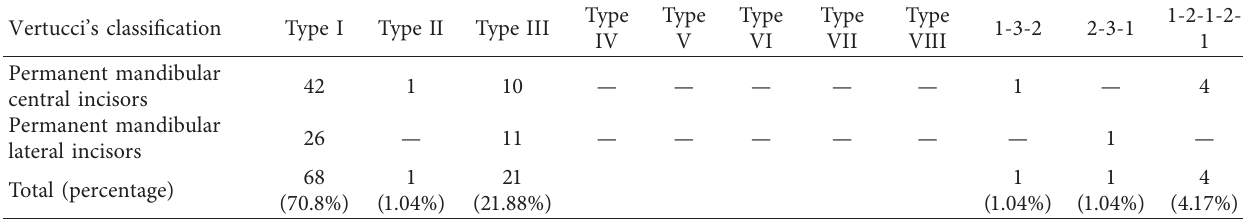
Table 3: Root canal anatomy of mandibular incisors according to Vertucci’s classification.